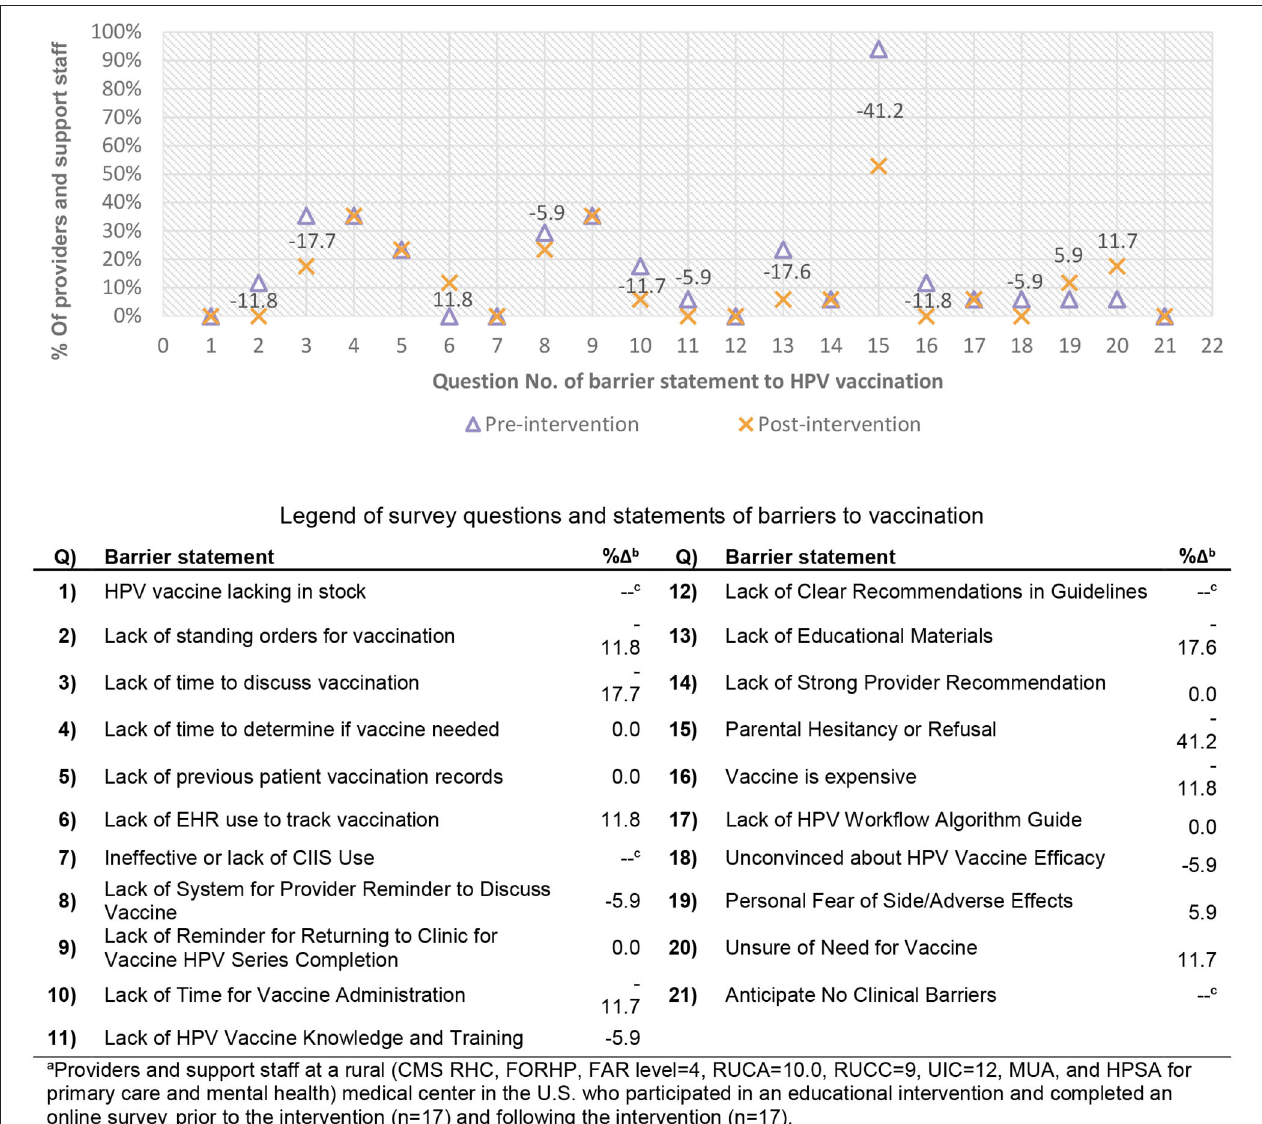
FIGURE 1 | Pre- and post-intervention survey of encountered HPV vaccination barriers among providers and support staff a with percent point change b . Legend of survey questions and statements of barriers to vaccination.